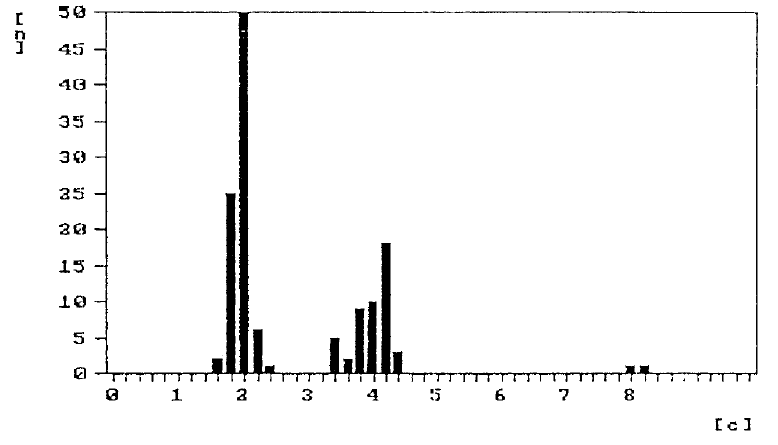
Fig. 6. DNA-histogram of brush-harvested squamous cells reveals drug-associated DNA-polyploidy (DNA-stemlines at 2c and 4c) without signs of DNA-aneuploidy (Fig.